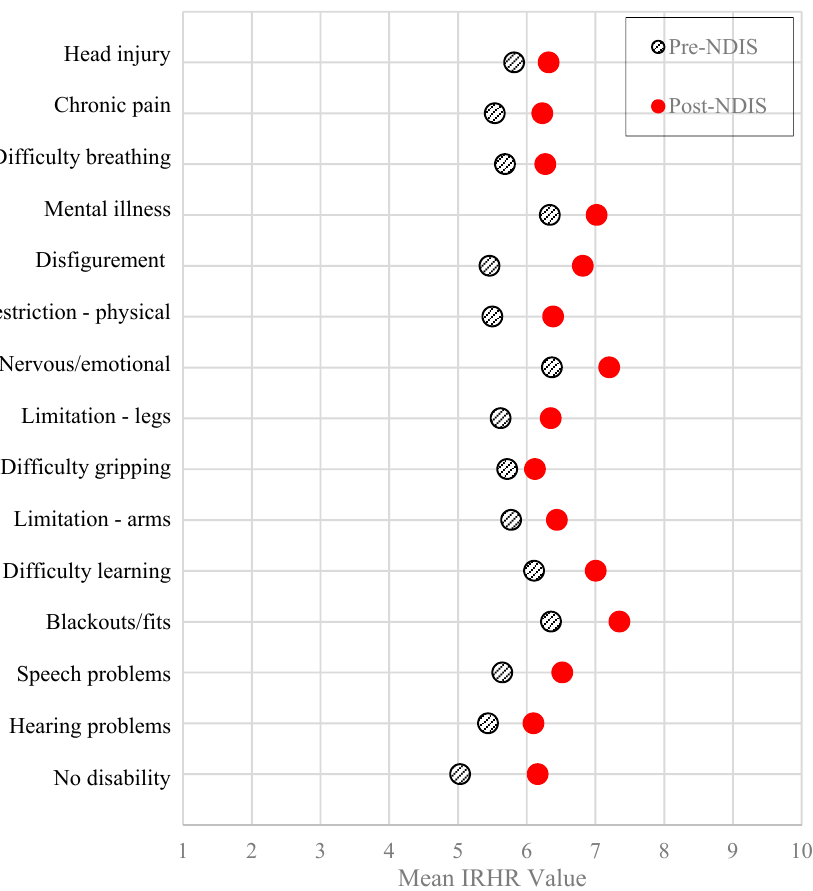
Figure 4. Mean Index of Relative Homelessness Risk Score by selected disability types, pre-NDIS and post-NDIS.